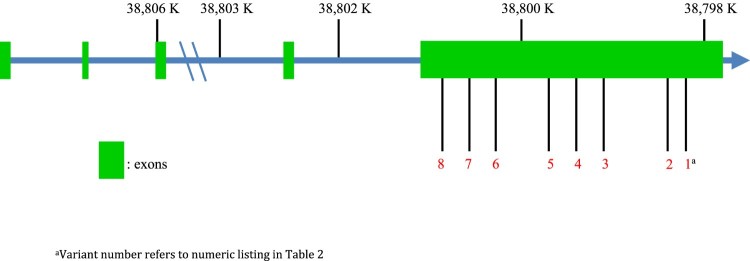
TLR1 variants of extreme phenotypes of melioidosis in the discovery set. Locations of eight variants in TLR1 identified during exonic sequencing of extreme phenotypes of Thai patients with melioidosis. Variant numeration is according to Table 2.